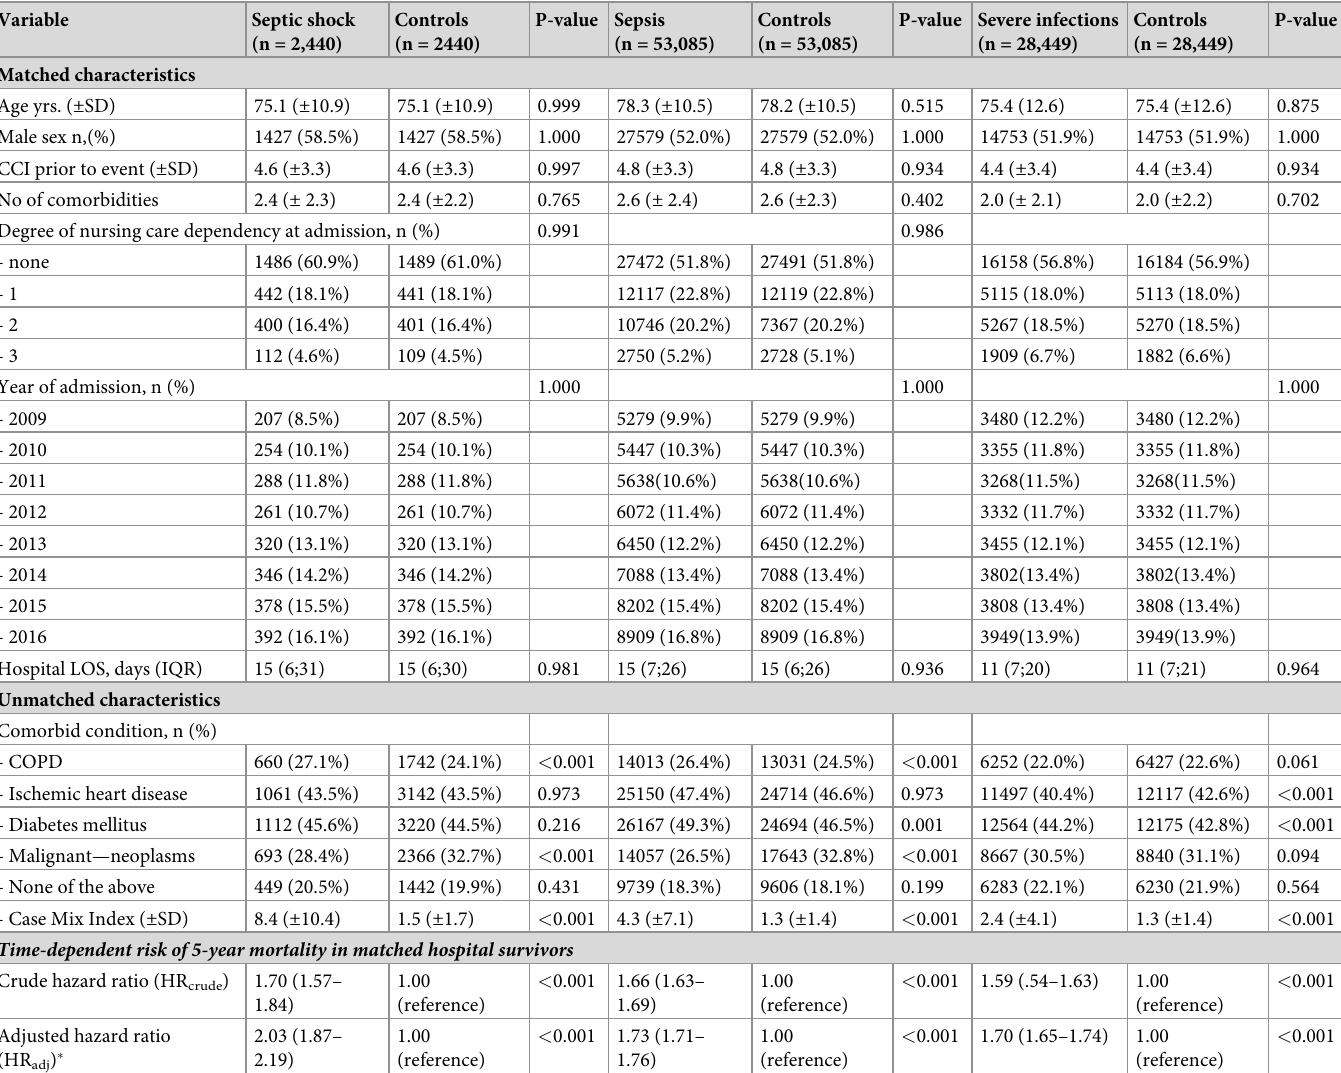
Table 1. Characteristics of patients with former septic shock, sepsis or severe infections without organ dysfunction each compared to matched controls.